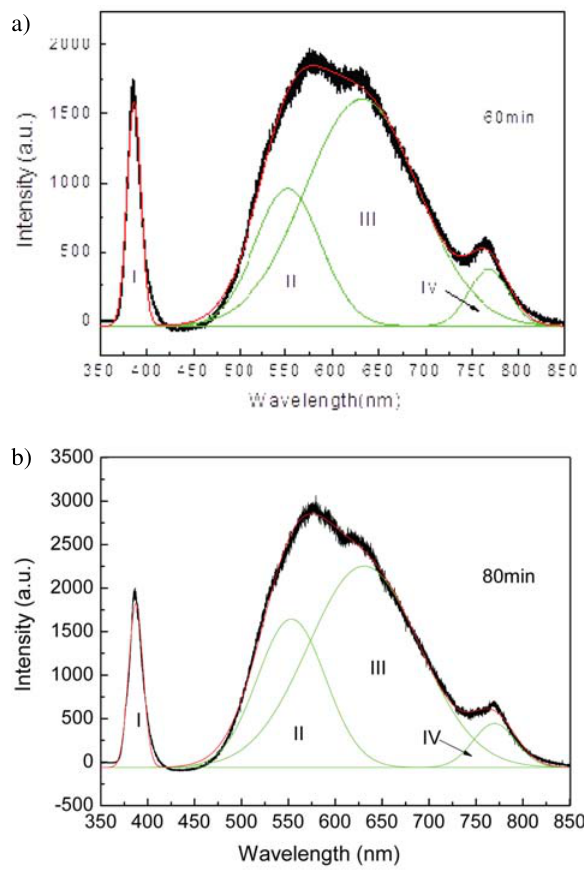
Fig. 6. The PL spectra of the ZnO microrods fabricated with vari- ous growth times: a) 60 min; b) 80 min. The spectra were deconvo- luted by four parts, marked as UV band (I), green band (II), orange band (III), and NIR band